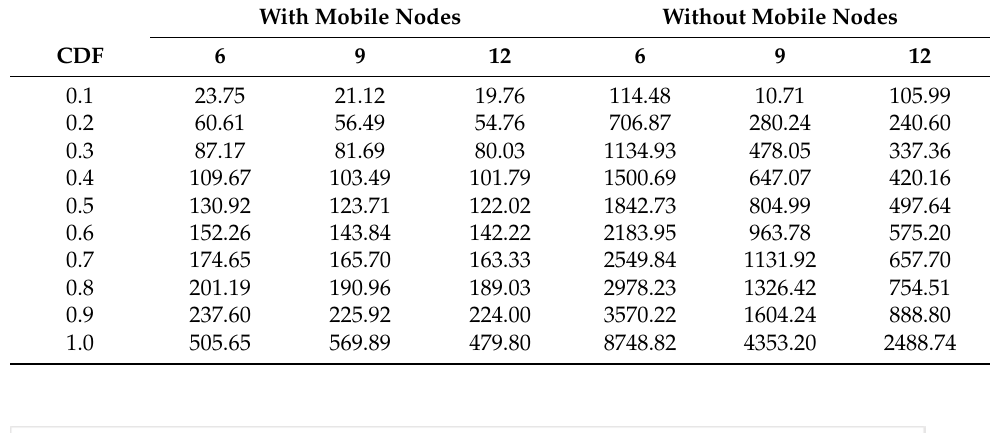
Table 2. The CDF of the average estimated errors for the proposed cooperative self localization algorithm.